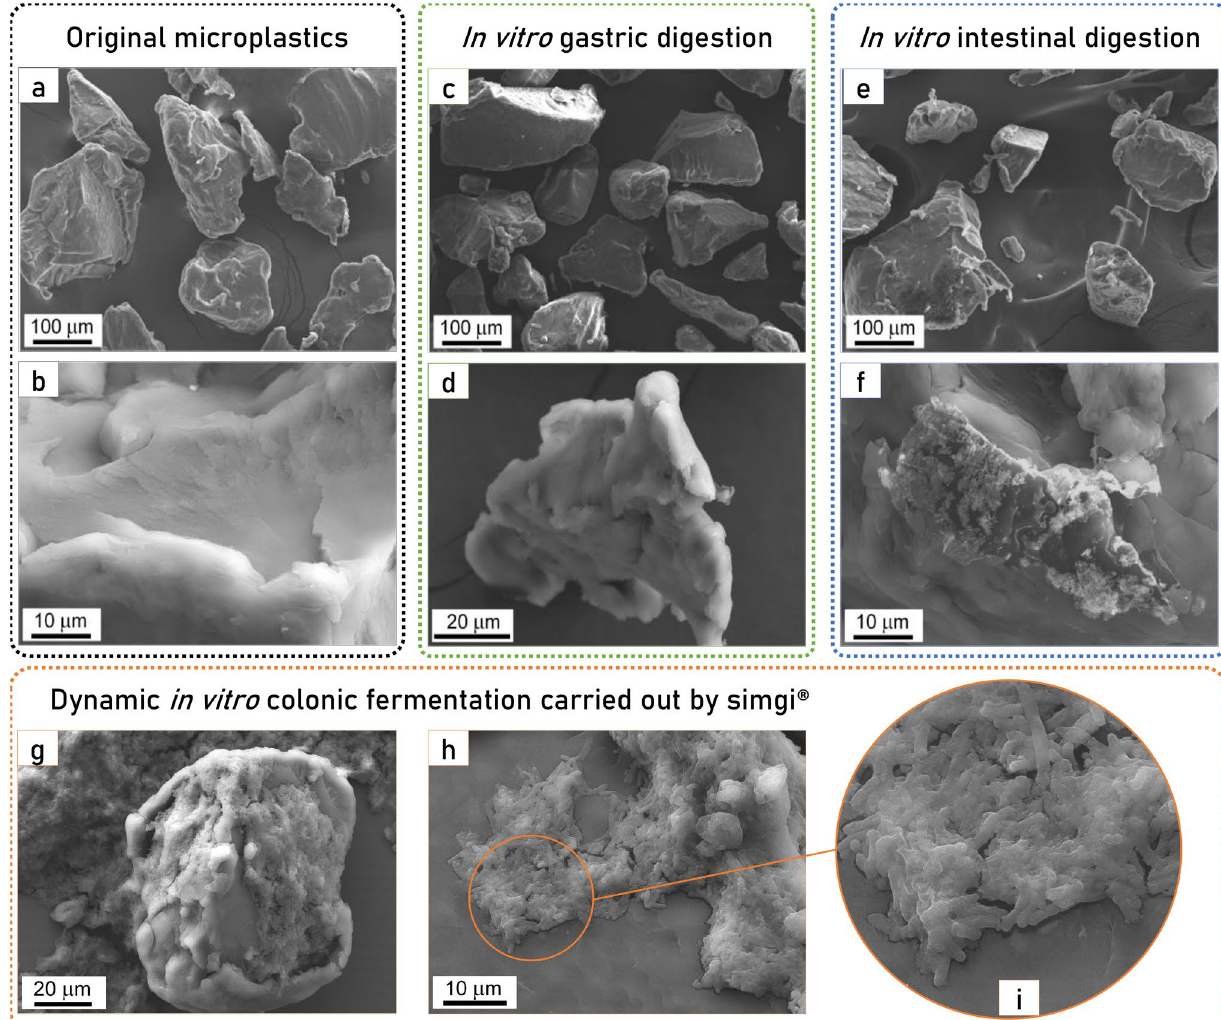
Figure 1. Micrographs by field emission scanning electron microscope (FESEM) of polyethylene terephthalate microplastics: ( a , b ) original PET microplastics (MPs), ( c ) and ( d ) PET MPs after in vitro gastric digestion, ( e , f ) PET MPs after in vitro gastrointestinal digestion, ( g – i ) PET MPs after in vitro gastrointestinal digestion and colonic